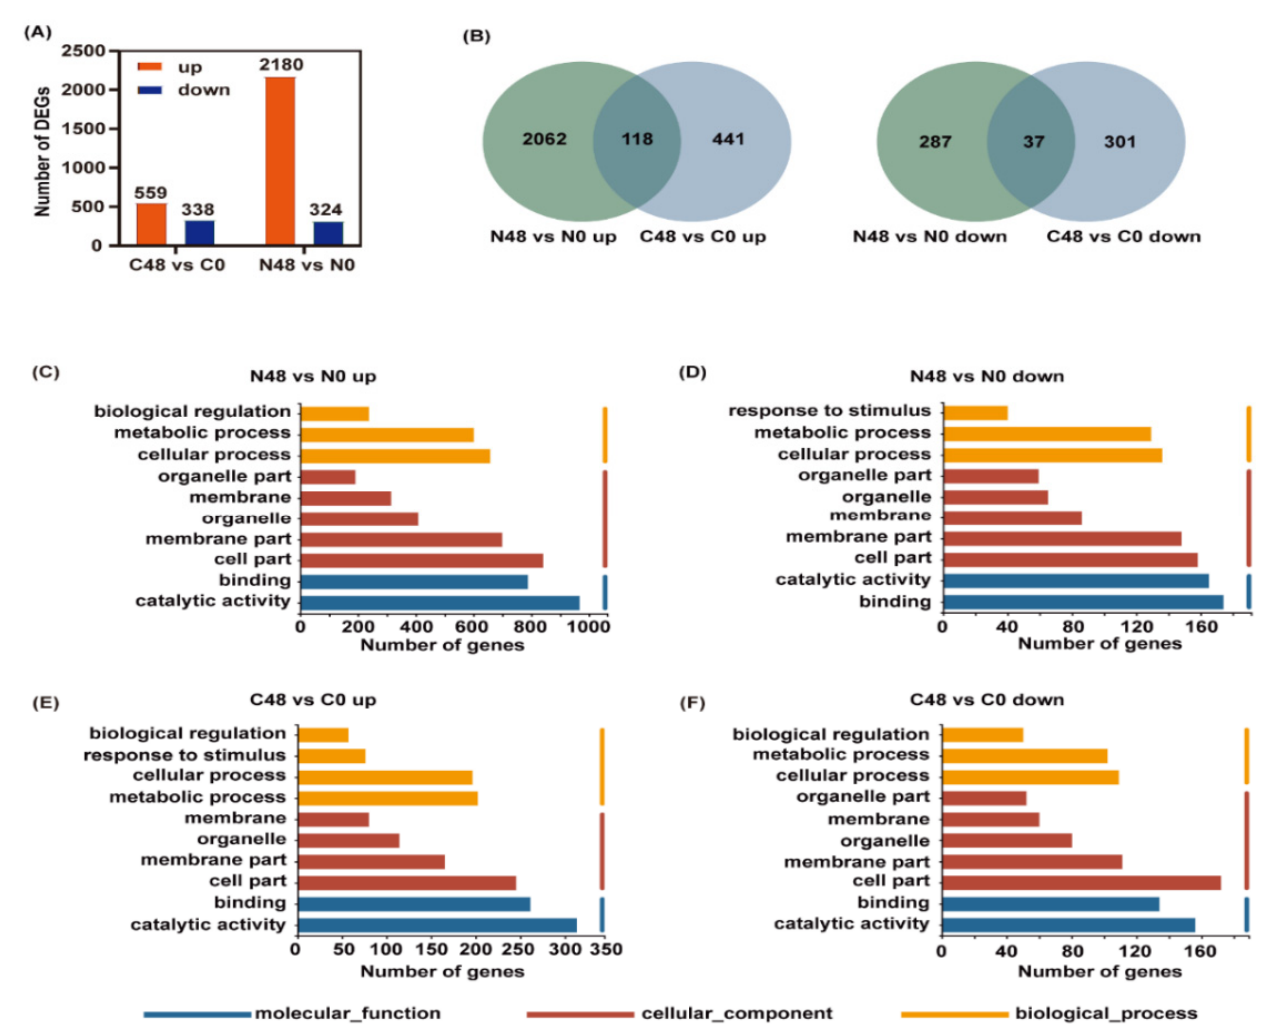
Figure 3. Differentially expressed genes (DEGs) and enriched GO terms analysis in Nipponbare and C331 variety fed by BPH for 48 h compared with untreated control. ( A ) Number of up- and downregulated DEGs in Nipponbare and C331 variety after BPH feeding. ( B ) Venn diagram of up- and downregulated DEGs in Nipponbare and C331 variety fed by BPH for 48 h compared with untreated control. ( C ) Enriched GO terms of upregulated DEGs in Nipponbare fed by BPH for 48 h (N48 vs. N0 up). ( D ) Enriched GO terms of downregulated DEGs in Nipponbare fed by BPH for 48 h (N48 vs. N0 down). ( E ) Enriched GO terms of upregulated DEGs in C331 fed by BPH for 48 h (C48 vs. C0 up). ( F ) Enriched GO terms of downregulated DEGs in C331 fed by BPH for 48 h (C48 vs. C0